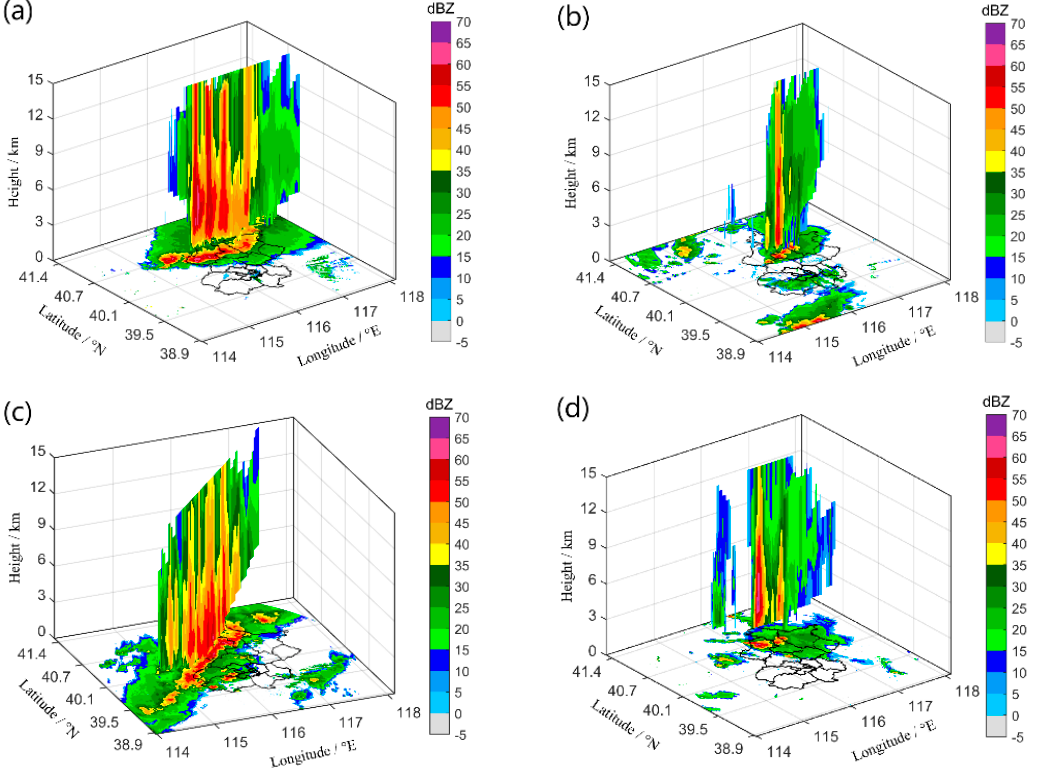
Figure 7. Vertical cross section of Z for different heights (unit: km) during a hailstorm in Beijing. ( a ) Vertical cross section of Z at 20:00 BJT on 25 June 2021; ( b ) vertical cross section of Z at 16:00 BJT on 30 June 2021; ( c ) vertical cross section of Z at 16:00 BJT on 1 July 2021; ( d ) vertical cross section of Z at 17:00 BJT on 9 August 2021.